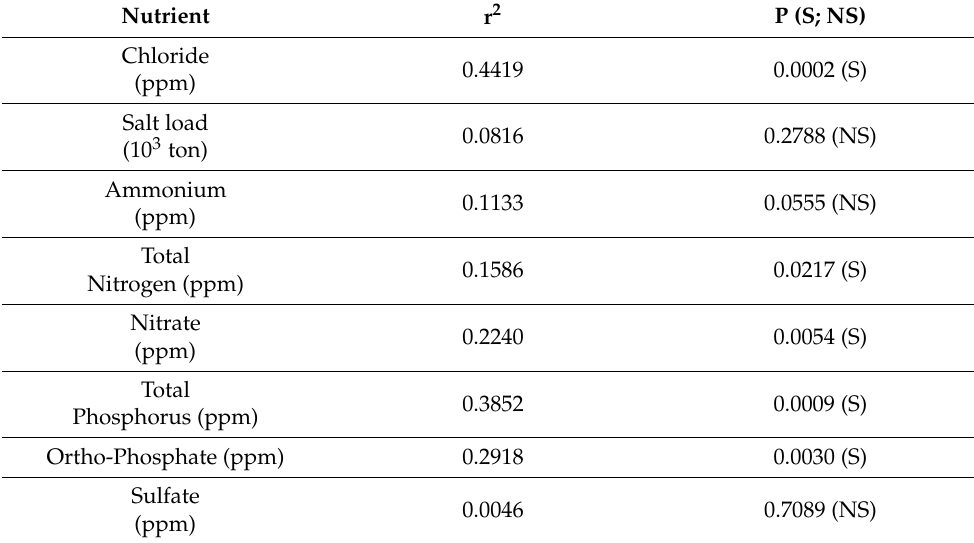
Table 1. Results of linear regression (r 2 , p) between multi-annual (1969–2001) means of nutrient concentrations (ppm): Chloride, Ammonium, Total Nitrogen, Nitrate, Total Phosphorus, Ortho- Phosphate, Sulfate, and a load of Salt (10 3 ton) vs. mean Water Level (mbsl). Significance indication (S = significant; NS = not significant) is given.